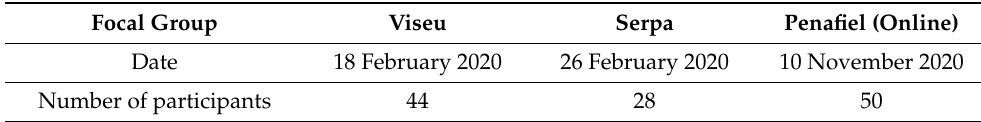
Table 2. Focal groups characteristics.